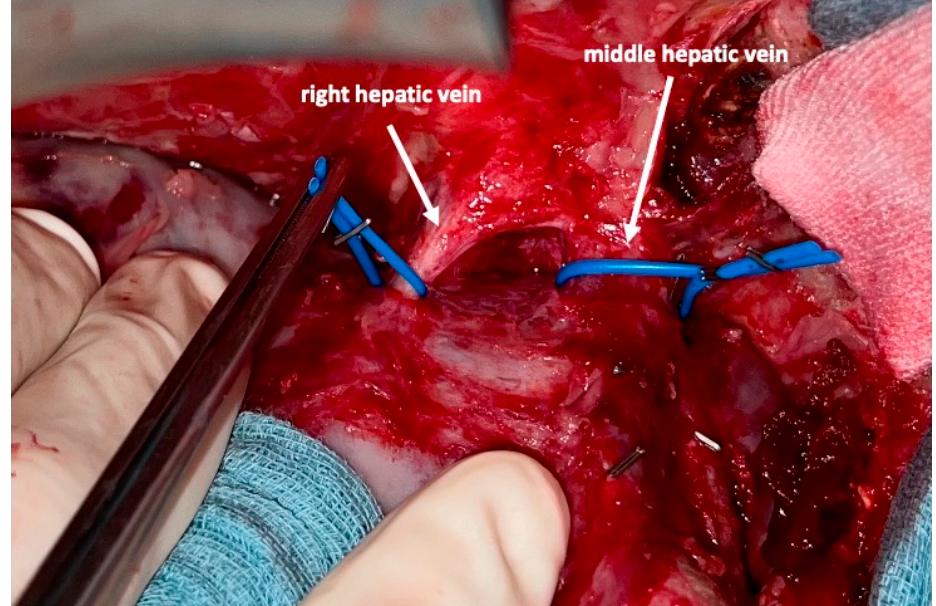
Figure 4. After transsection of the liver the middle and right hepatic veins are marked with a blue vessel loop each. This facilitates division of these vessels after regeneration of the left lobe.